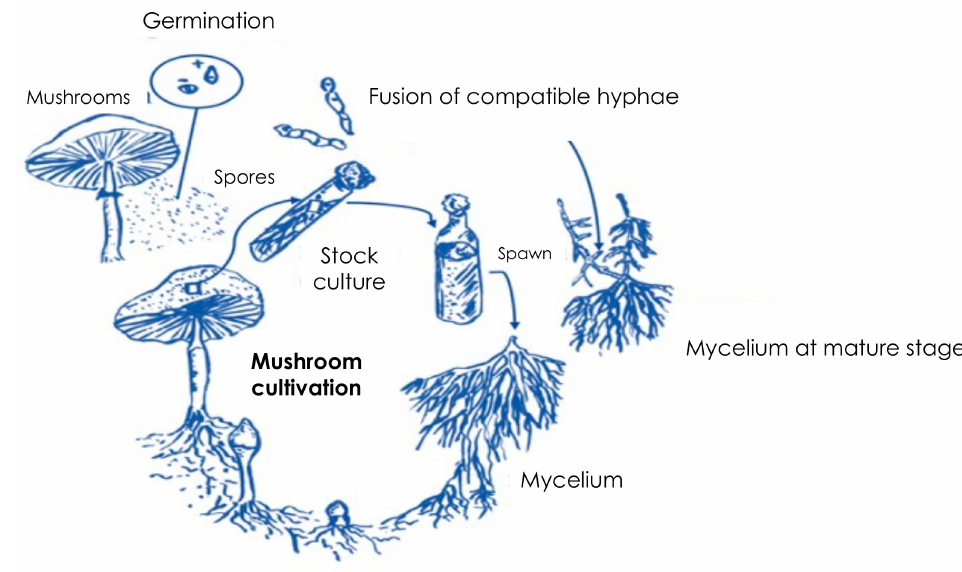
Figure 6. Lifecycle of mushroom and spawn